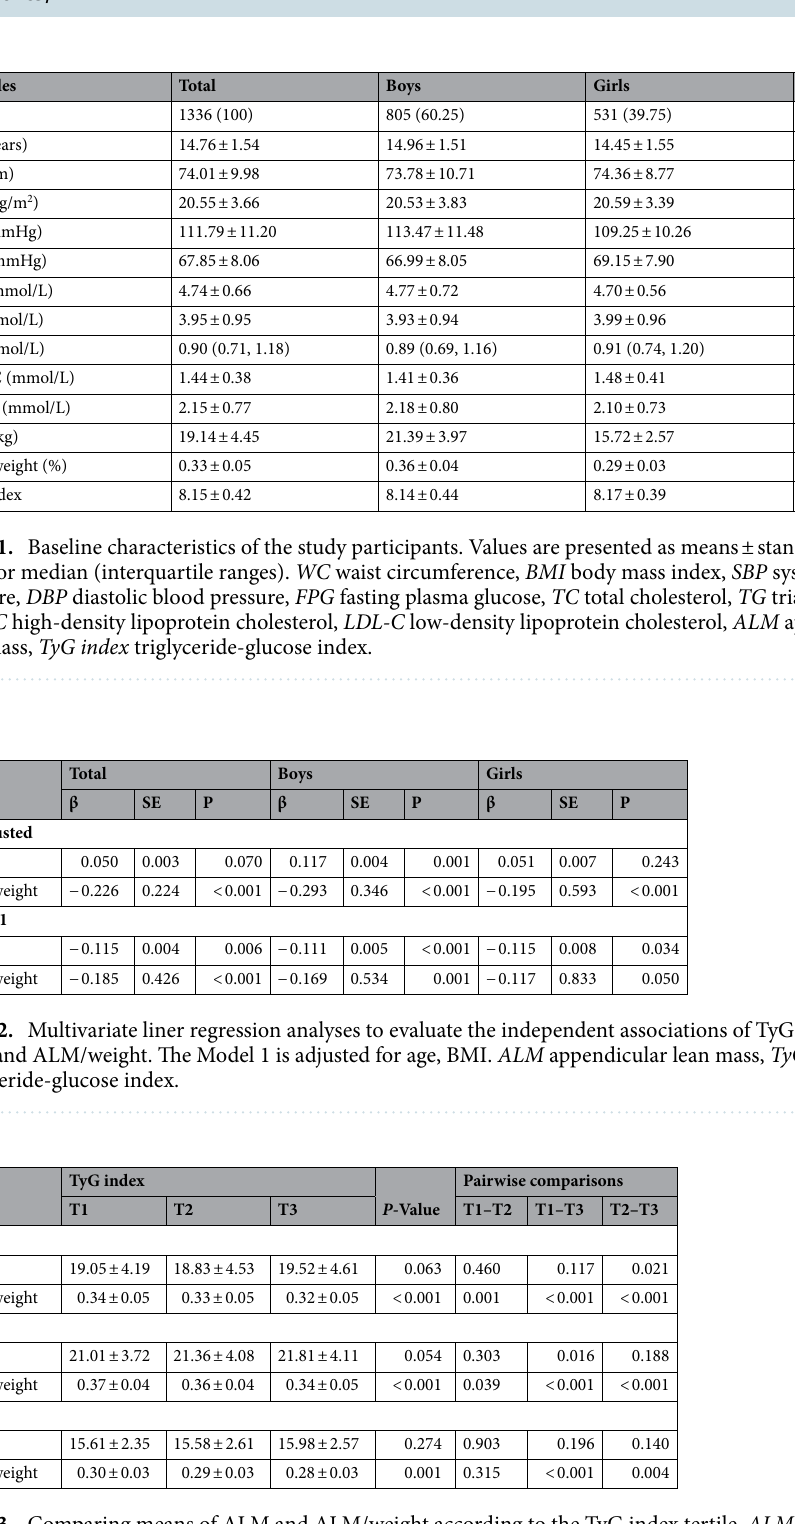
Table 3. Comparing means of ALM and ALM/weight according to the TyG index tertile. ALM appendicular lean mass, TyG index triglyceride-glucose index.